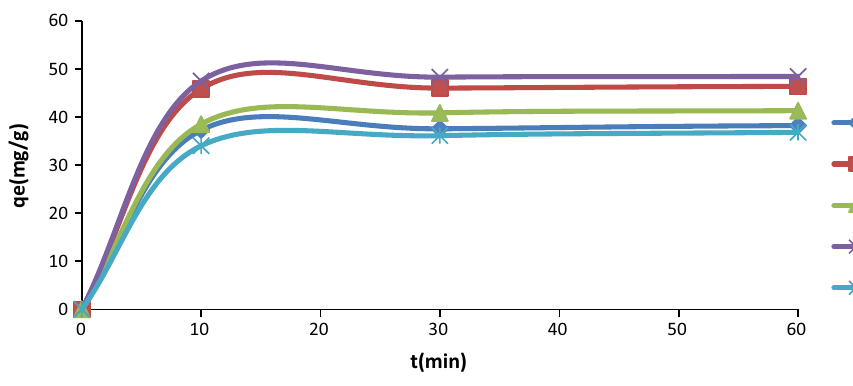
Fig. 6 Effect of contact time on the uptake of Zn(II), Ni(II), Cu(II), Pb(II) and Cd(II) by chitin